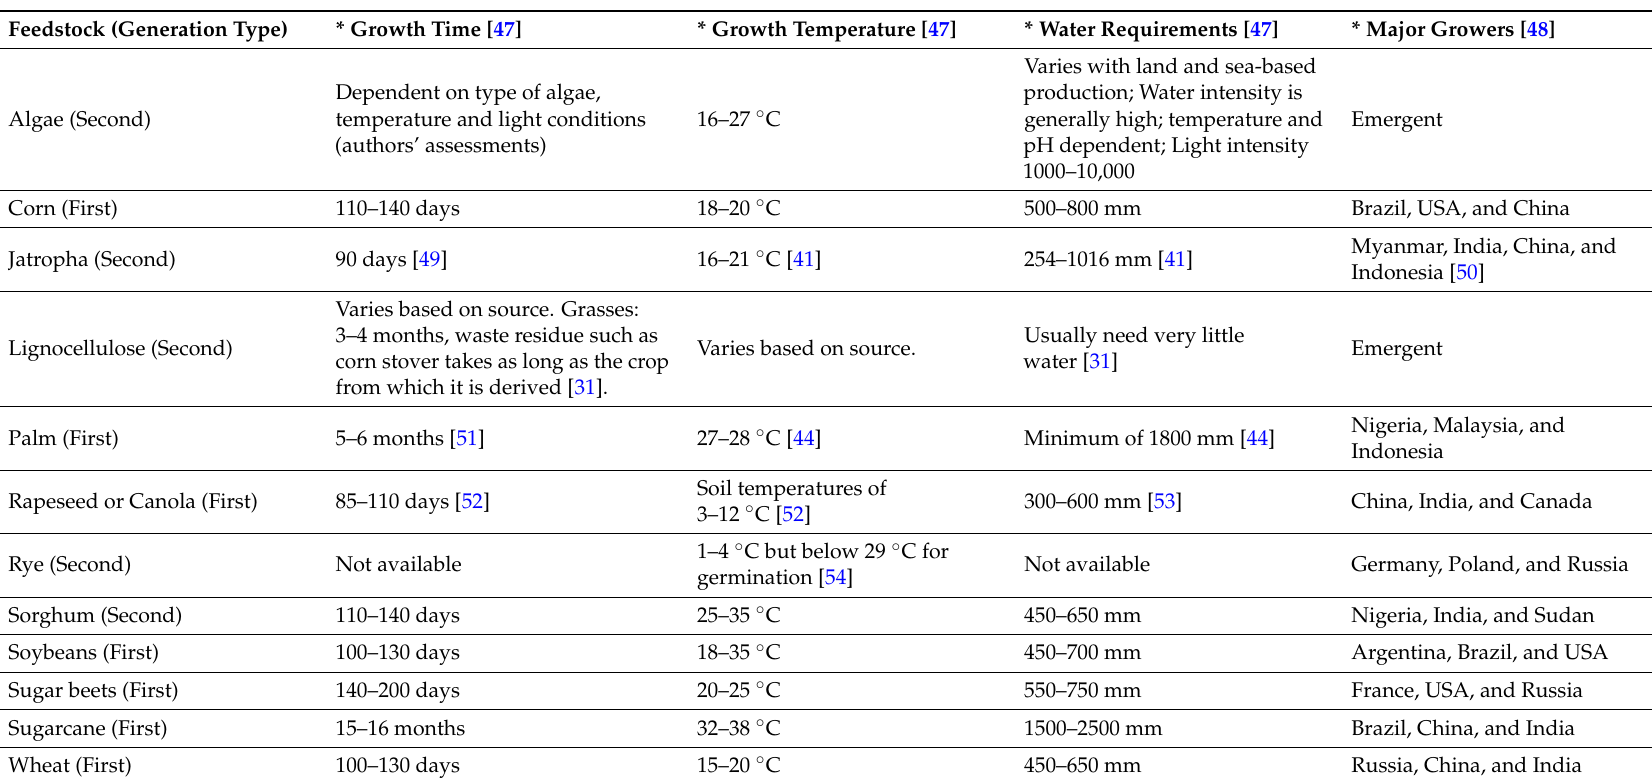
Table 2. Feedstock and